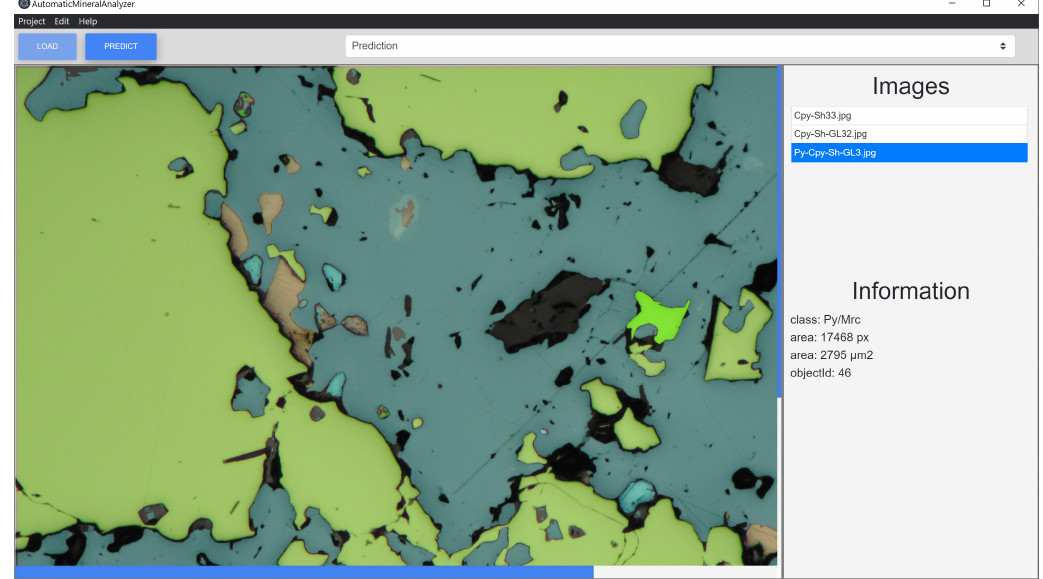
Figure 6. Graphical user interface of the developed tool for automatic identification of minerals in images of polished sections. of mineral on the image, which is very useful for practical tasks of